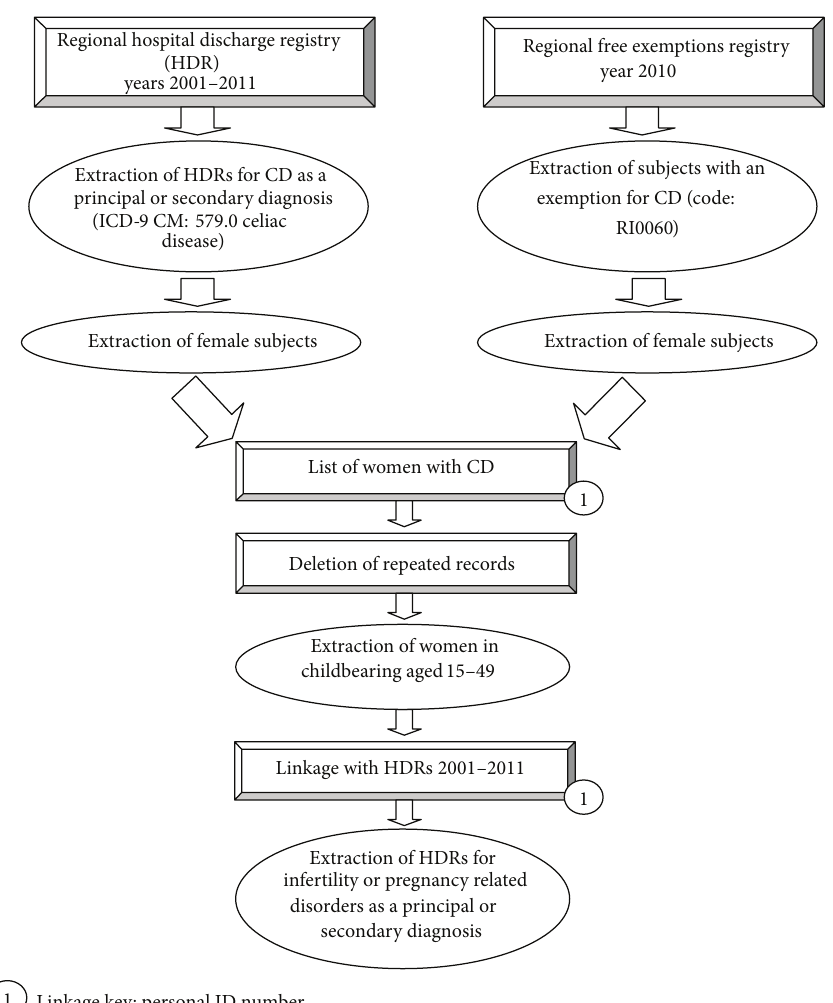
Figure 1: Algorithm of the population analysis from available registries. Apulia, years 2001–2011.